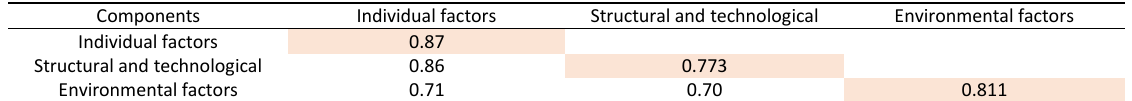
Table 6. Variance derived from components and their correlations